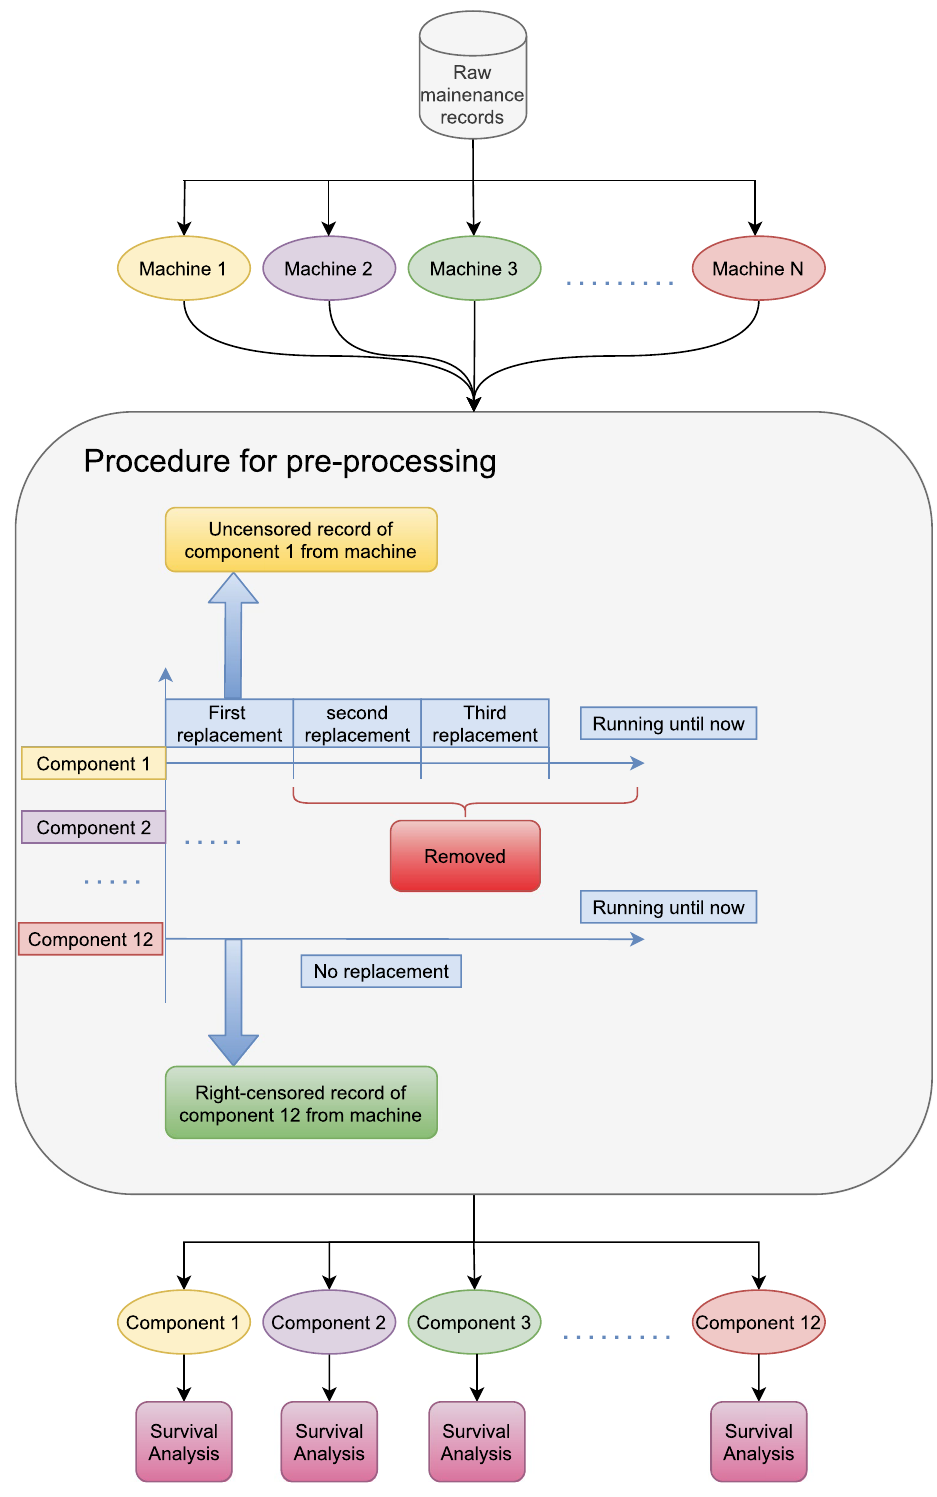
Figure 3. Data pre-processing diagram. This diagram shows how we obtained our survival data from the raw maintenance